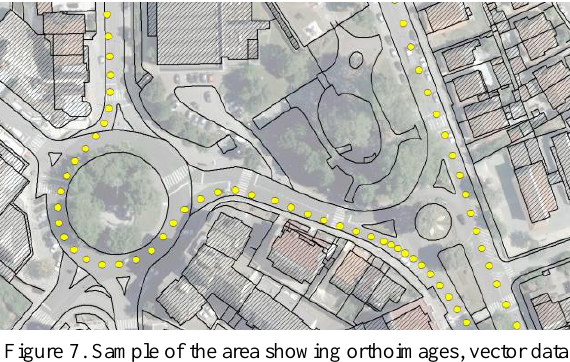
Figure 7. Sample of the area showing orthoimages, vector data and locations acquired with the MMS (yellow dots).